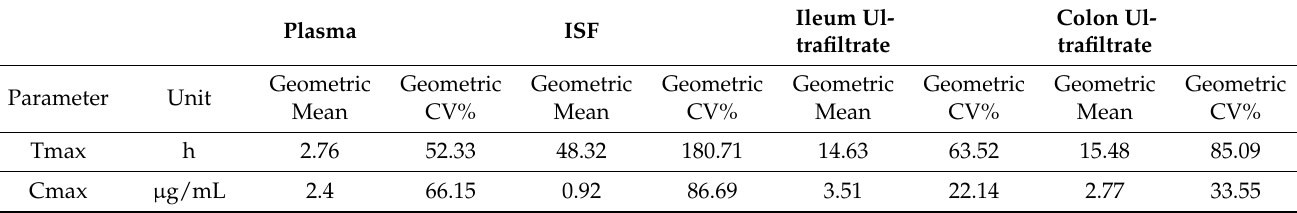
Table 3. Selected PK parameters following analysis for the steers administered 40 mg/kg florfenicol SC once. The geometric mean and geometric CV% are provided. T max : time to maximum concentration; C max : the maximum drug concentration; AUC: area under the time–concentration